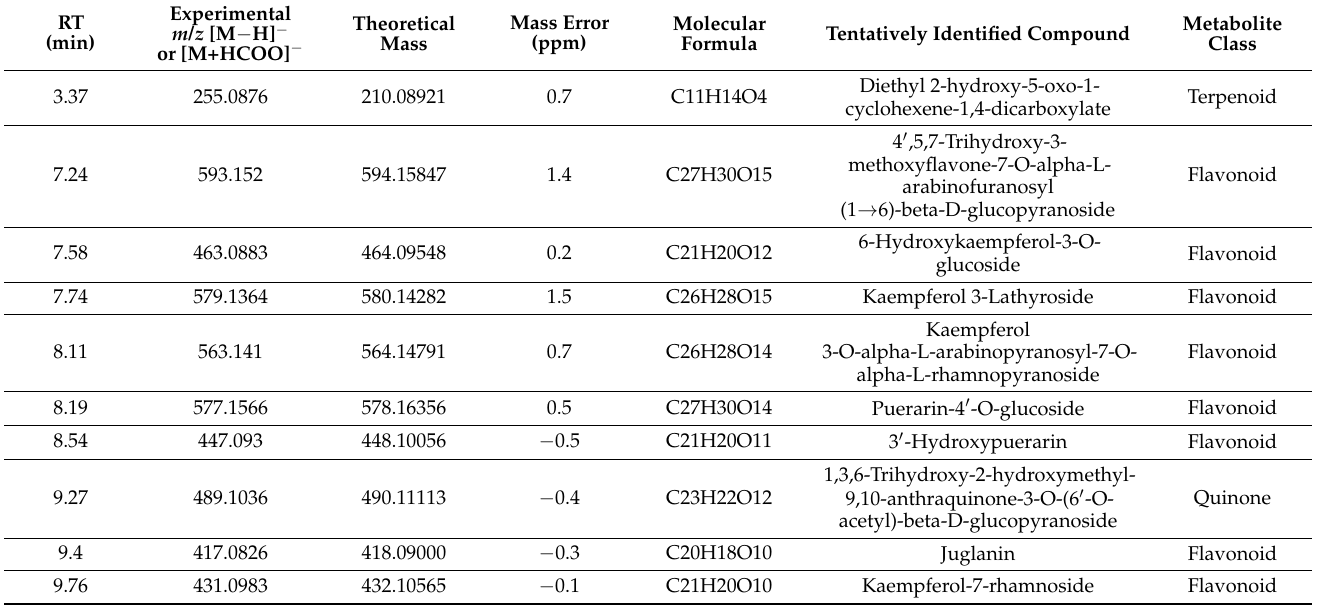
Figure 1. Base peak ion(BPI) chromatogram of D. lacera ( A ), and D. bissetiana ( B ) extracts by UPLC- QTOF-MS analysis. Table 1. The bioactive components of D. lacera based on the UPLC-QTOF-MS